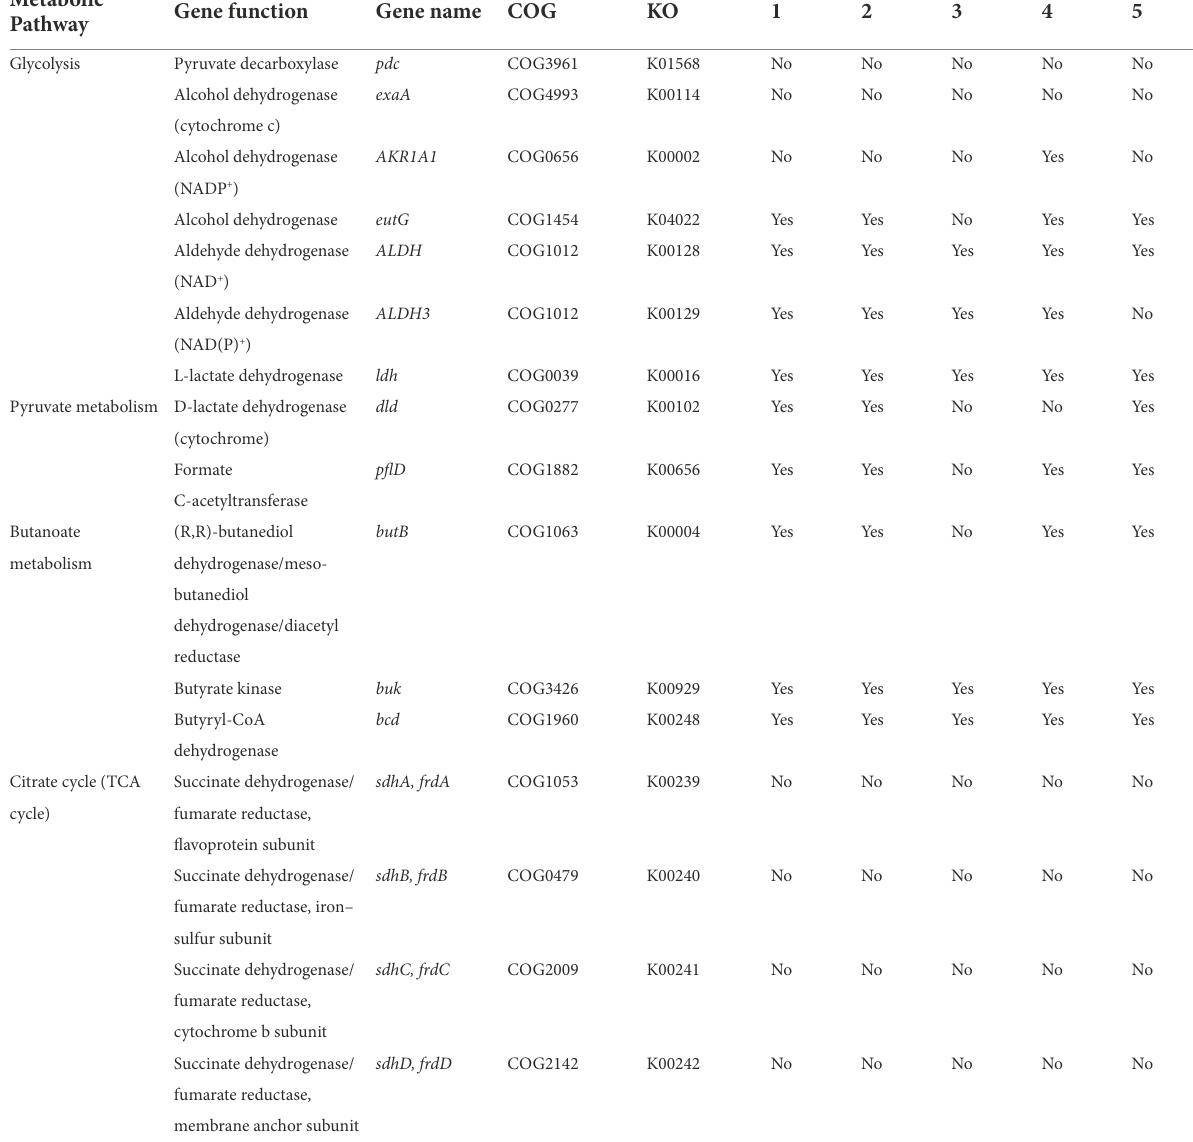
TABLE 4 Presence of genes related to fermentative metabolism in Fusibacter genomes. Metabolic Gene Pathway